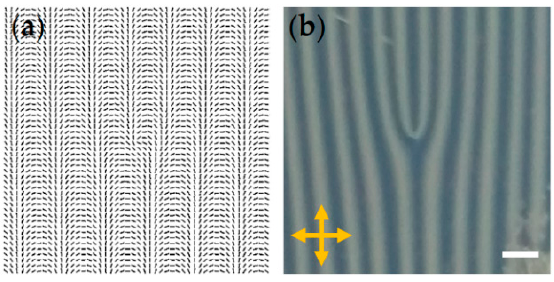
Figure 2. ( a ) The scheme of the director distribution of an LC FPG with m = 1 and Λ ≈ 1.2 mm; ( b ) corresponding photo under crossed polarizers; the scale bar is 1 mm.